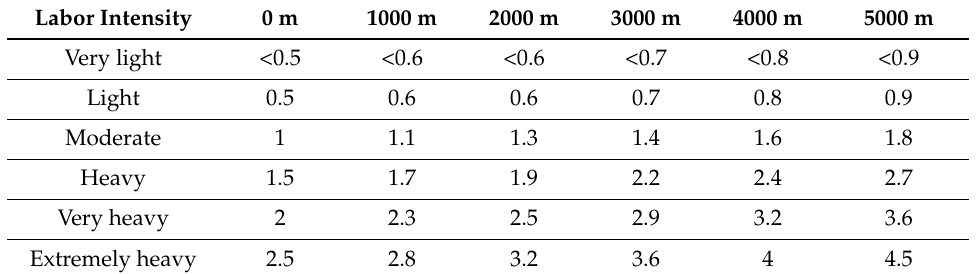
Table 6. Minimum oxygen consumption under different labor intensities at different altitudes (L/min).